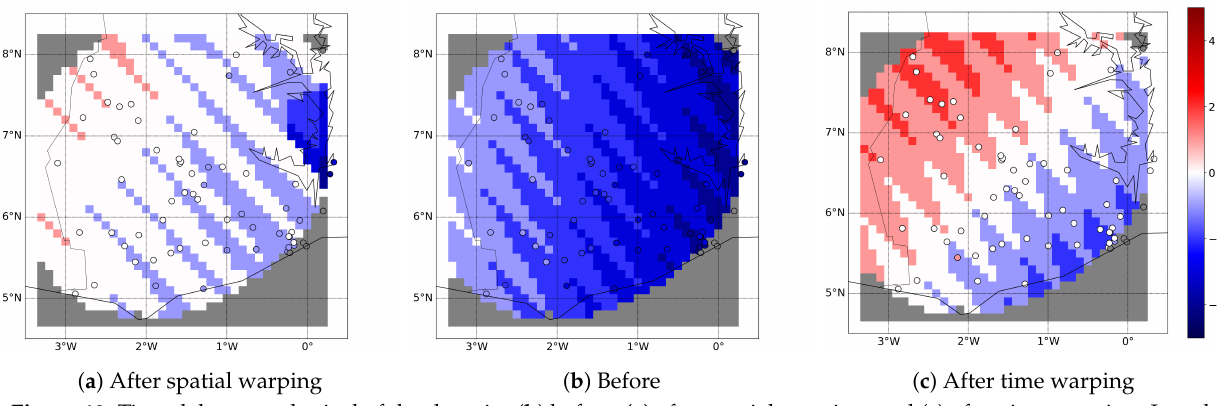
Figure 10. Time delay at each pixel of the domain: ( b ) before, (a) after spatial warping, and ( c ) after time warping. In red, the peak in u is late (compared to the one in the target field v ). In blue, the peak in u is in advance. In grey, one of the time series does not have a peak (rainfall < 0.1